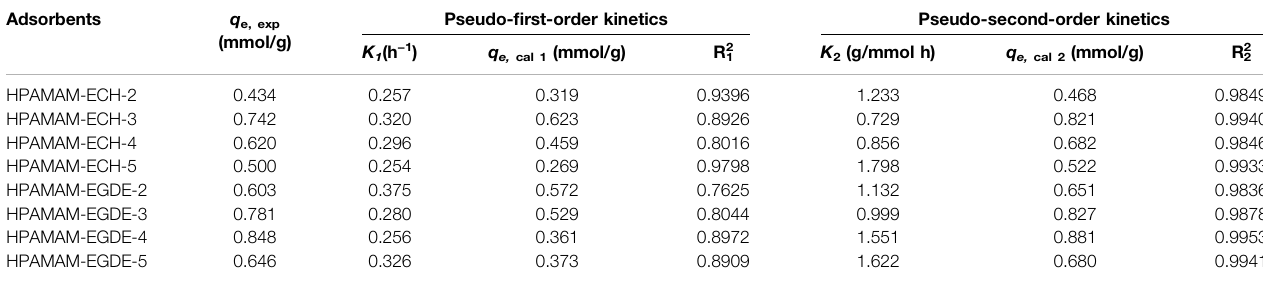
TABLE 4 | Kinetic parameters for the adsorption of Hg(II) on all samples. Adsorbents q e, exp Pseudo- fi rst-order kinetics Pseudo-second-order (mmol/g)